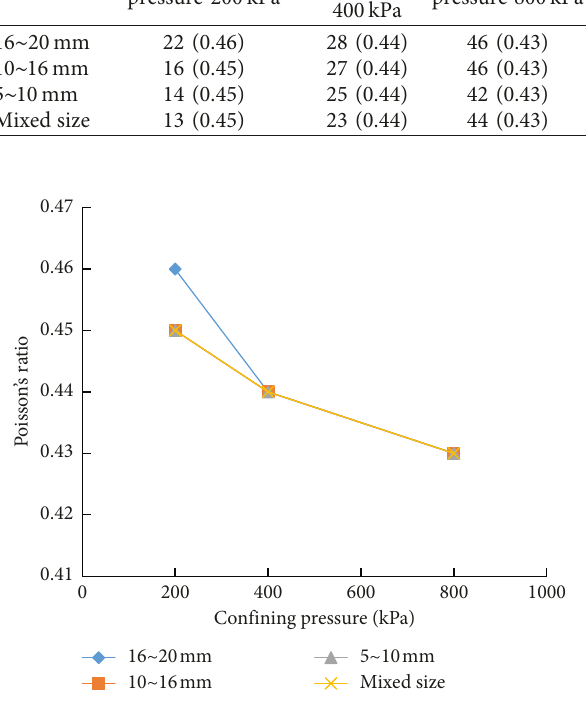
Figure 8: Poisson’s ratio variation related to rock